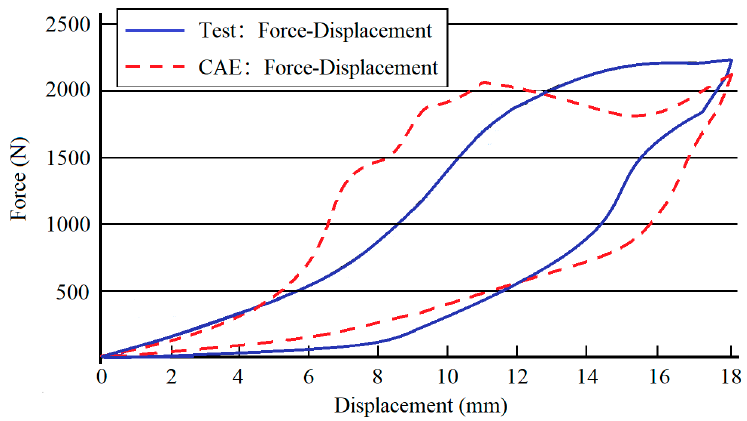
Figure 13. Comparison diagram of load-displacement curve between simulation and test.